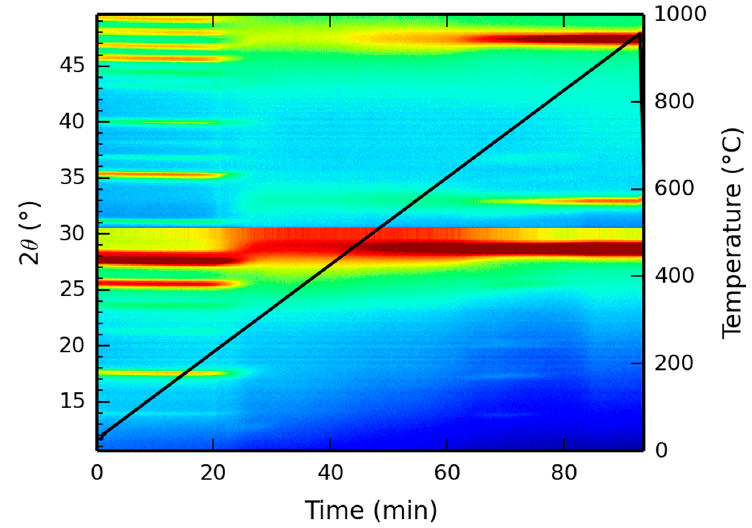
Figure 7. High temperature XRD analysis of the Ce-LDH structure between 0 °C and 1000 °C, heated ◦ C / at 10 °C/min. at 10